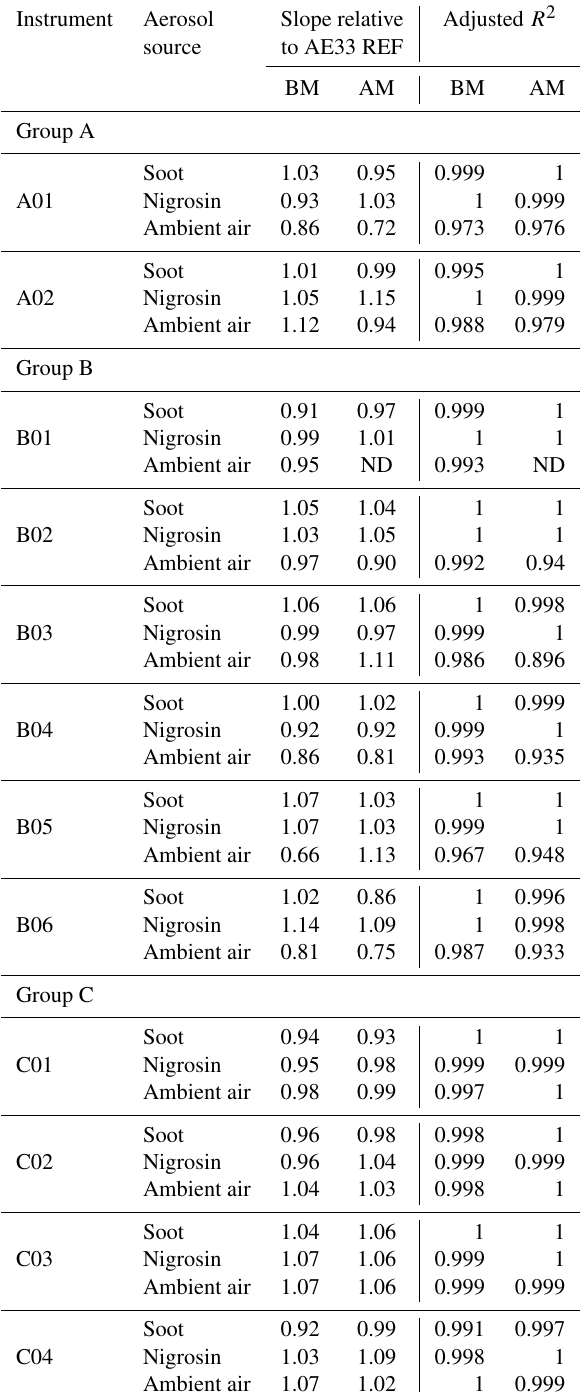
Table 4. Relative slope and correlation coefficients for total least squares regression forced through the origin for eBC mass concen- trations (880nm) before and after